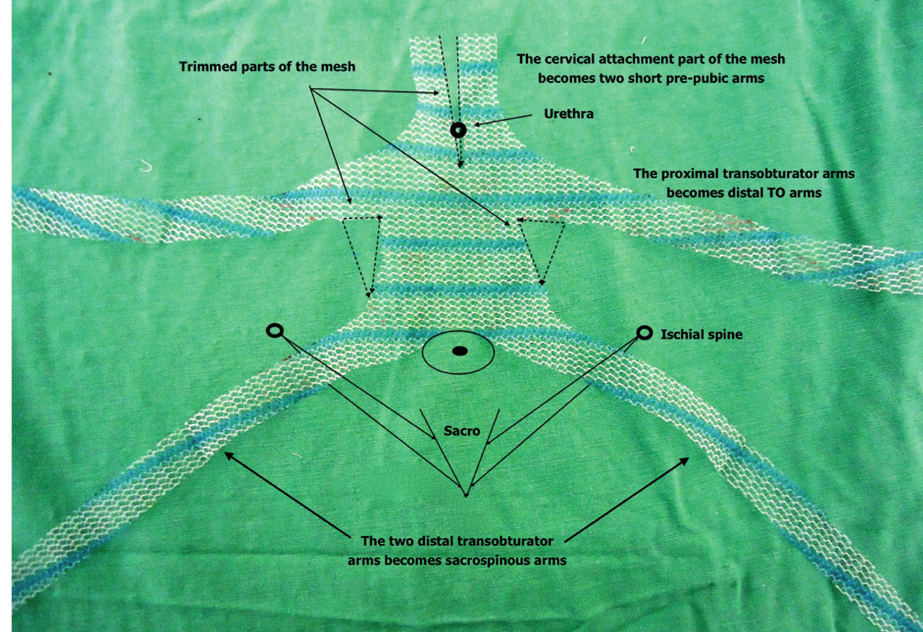
figure 3 - Inverted Anterior